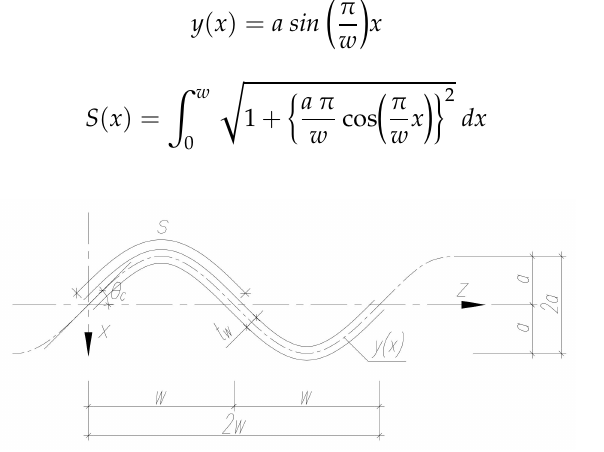
Figure 6. Geometric features of the sinusoidal